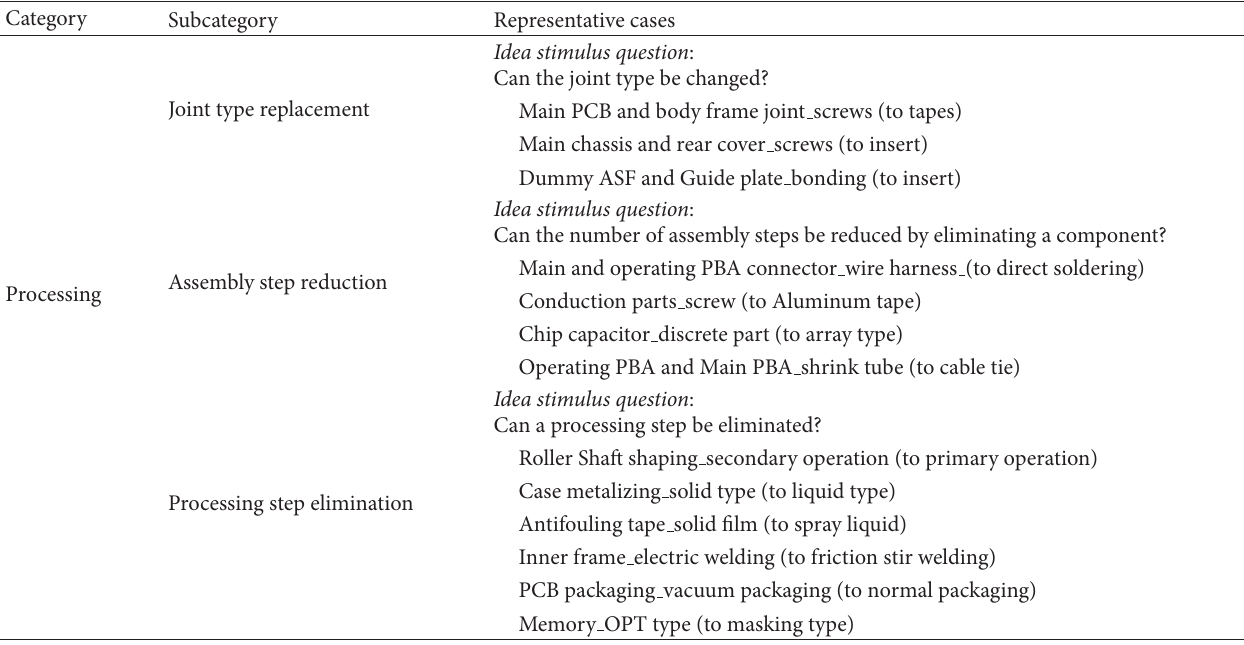
Table 7: Processing checklist and representative